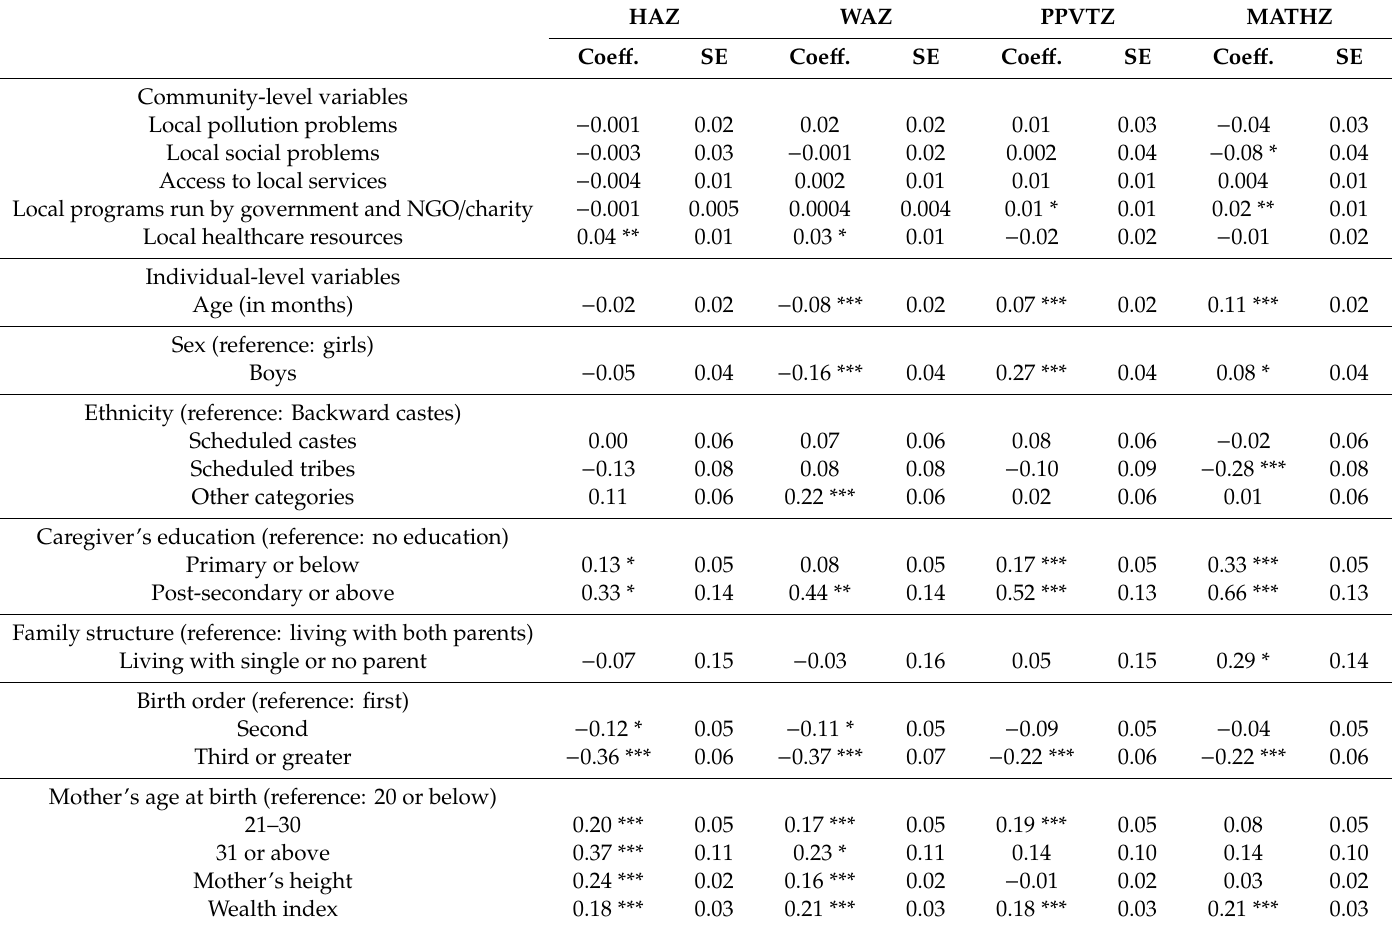
Table 2. Estimates (coe ff .) and standard errors (SEs) from the fixed part of multivariate 3-level linear models for individual- and community-level variables. HAZ WAZ PPVTZ MATHZ Coe ff . SE Coe ff . SE Coe ff . SE Coe ff . SE